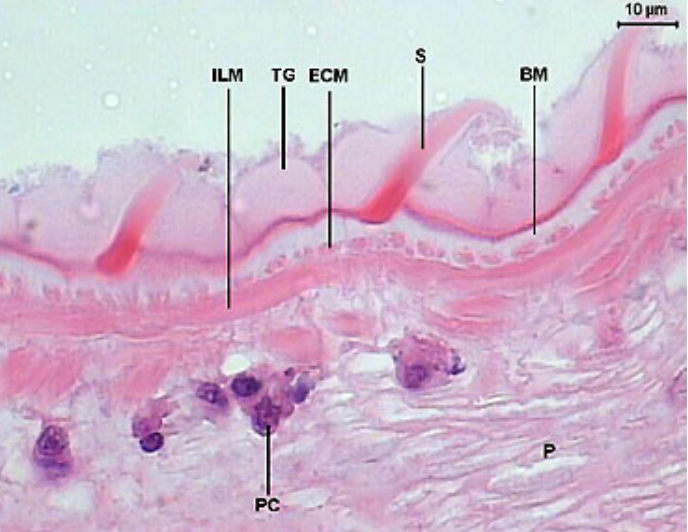
Figure 3. Longitudinal section of Sticholecitha serpentis . TG – tegument, BM – basement membrane, ECM – external circular musculature, ILM – internal longitudinal musculature, P – parenchyma, S – spines, PC – parenchymal cells.